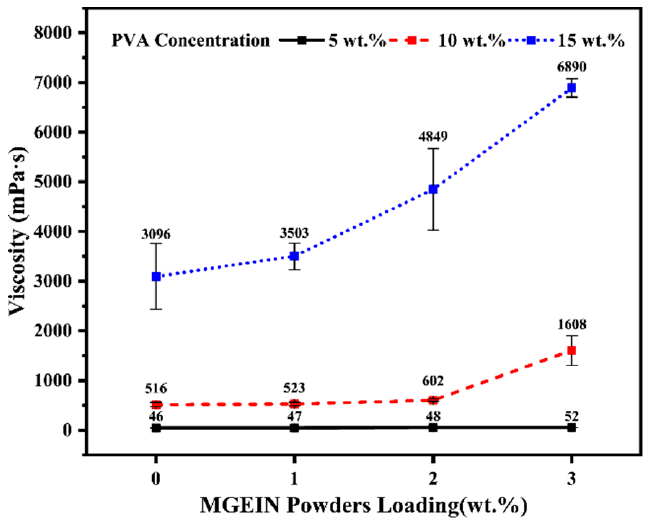
Figure 3. Viscosity of Gr/PVA impregnation mixtures.